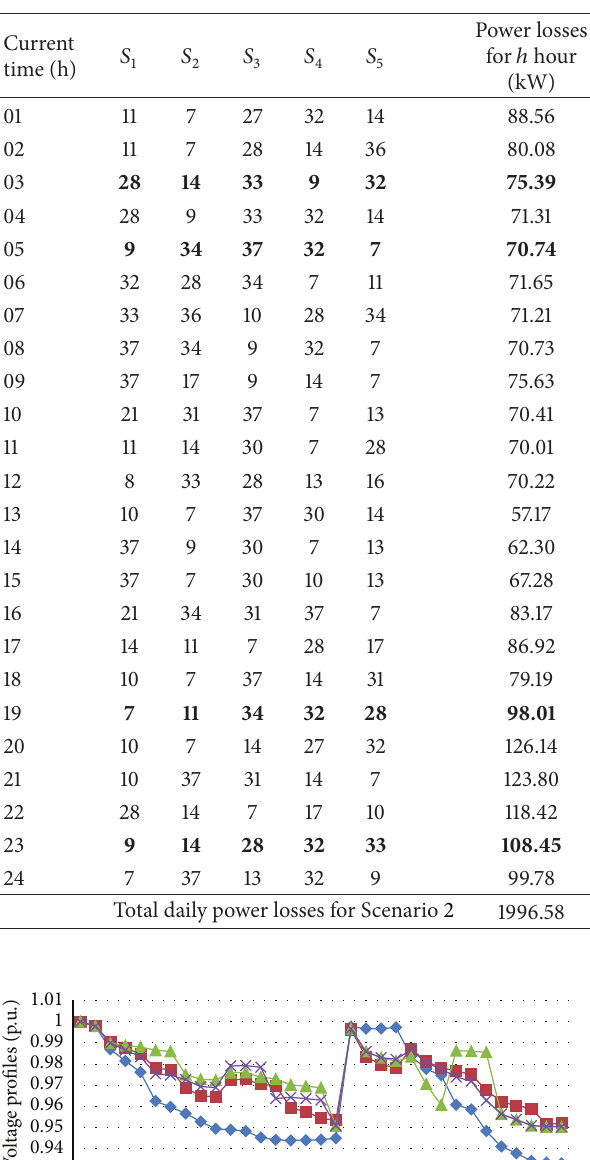
Table 4: Results of matrix consists of ℎ feasible configurations and their power loss obtained in Part 1.